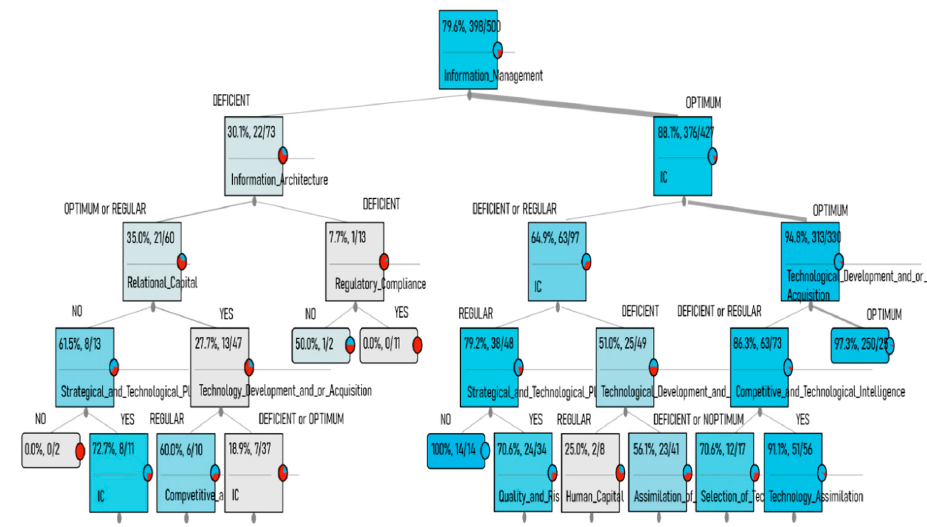
Figure 5. Decision tree for the knowledge management model.